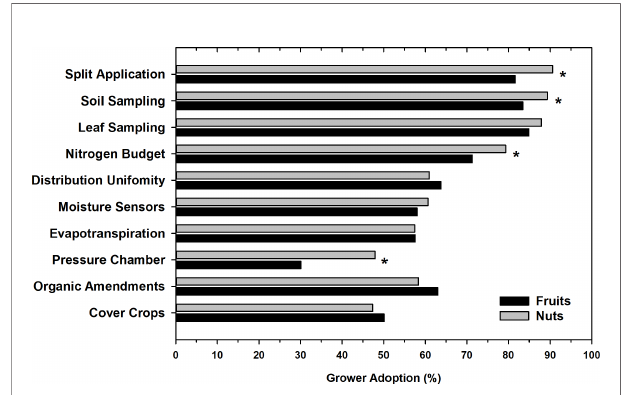
FIGURE 2 | Adoption percentage (%) of conservation practices for nitrogen (N) management by by fruit and nut growers. Differences at p < 0.05 reported by an asterisk (*) signify the effect is signi fi cant between fruit and nut growers using a Kruskill-Wallis